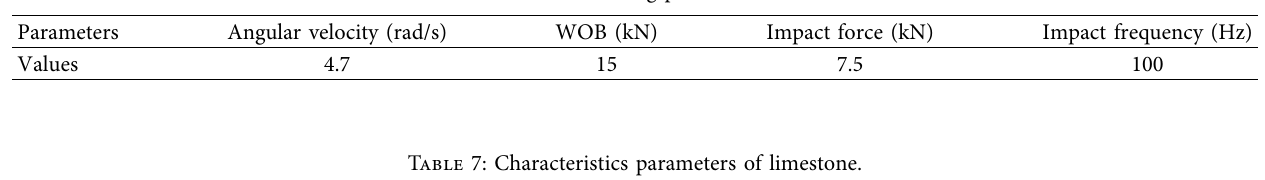
Table 6: Drilling parameters.